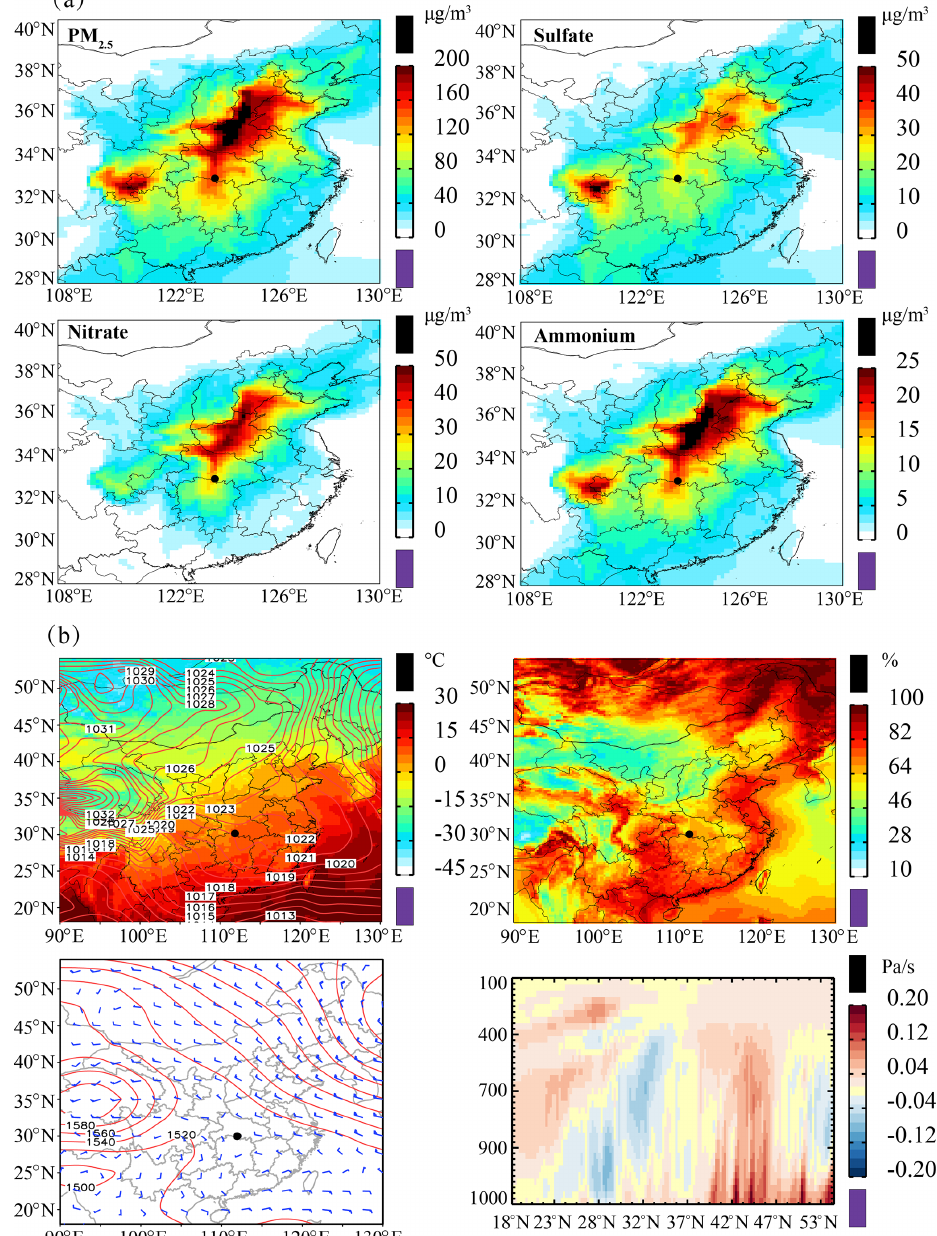
Figure 7. (a) Spatial distribution of PM 2 . 5 , sulfate, nitrate, and ammonium concentrations averaged over SW-type synoptic controls (18– 25 November 2013) simulated by GEOS-Chem control simulation (µg / m 3 ). (b) Meteorological conditions of the SW type: sea level pressure (red line) and temperature (color shades), surface relative humidity (%) fields, 850hPa wind and geopotential height (red line), and height– latitude cross sections of vertical velocity